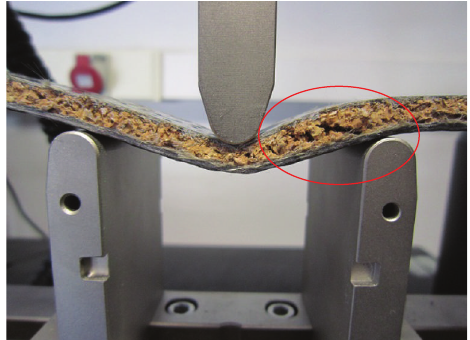
Figure10:Criticalfailureofthesandwichsamplebyshearcavitation in the cork